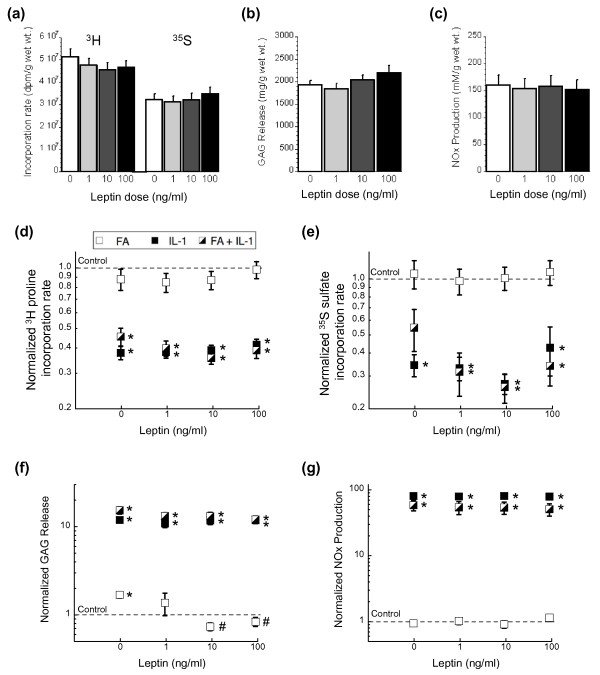
Effect of physiologic leptin ± IL-1α and fatty acid on healthy cartilage extracellular matrix homeostasis. Forty-eight-hour in vitro tissue culture experiments were performed on macroscopically intact porcine femoral articular cartilage explants to determine the acute effect of leptin stimulation on extracellular matrix synthesis and degradation. (a) Effect of leptin stimulation on collagen and sulfated glycosaminoglycan (S-GAG) synthesis rates determined by radioisotope incorporation of [3H]proline and [35S]sulfate, respectively (N = 9 joints, n = 5 explants per joint). Data are normalized to the average control value per joint. (b) S-GAG release from cartilage explants due to leptin stimulation (N = 12, n = 5). (c) Nitrite and nitrate (NOx) production from cartilage explants due to leptin stimulation (N = 9, n = 5). Leptin-stimulated conditions were not significantly different from control values (P > 0.05). Effect of leptin stimulation on cartilage (d) collagen synthesis, (e) S-GAG synthesis, (f) S-GAG release, and (g) NOx production when co-treated with 0.5 mM fatty acids (FA) or 0.1 ng/ml IL-1α separately or combined (N = 3, n = 5). FA treatment was a 1:1 ratio of palmitic:oleic acids. y axes are on a log scale. *P < 0.05 versus untreated control (dashed line). #P < 0.05 versus zero leptin condition. Data shown are mean ± standard error of the mean.